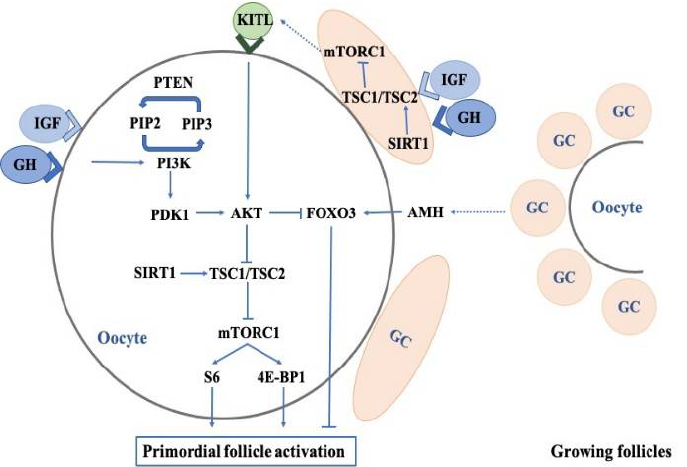
Figure 1. The pathways and their roles in the regulation of primordial follicle activation and quiescence. Multiple pathways, including PI3K-PTEN-AKT-FOXO3, mTOR-KITL, GH/IGF1, AMH, and SIRT, converge in the mammalian ovaries to regulate the quiescence and activa- tion of primordial